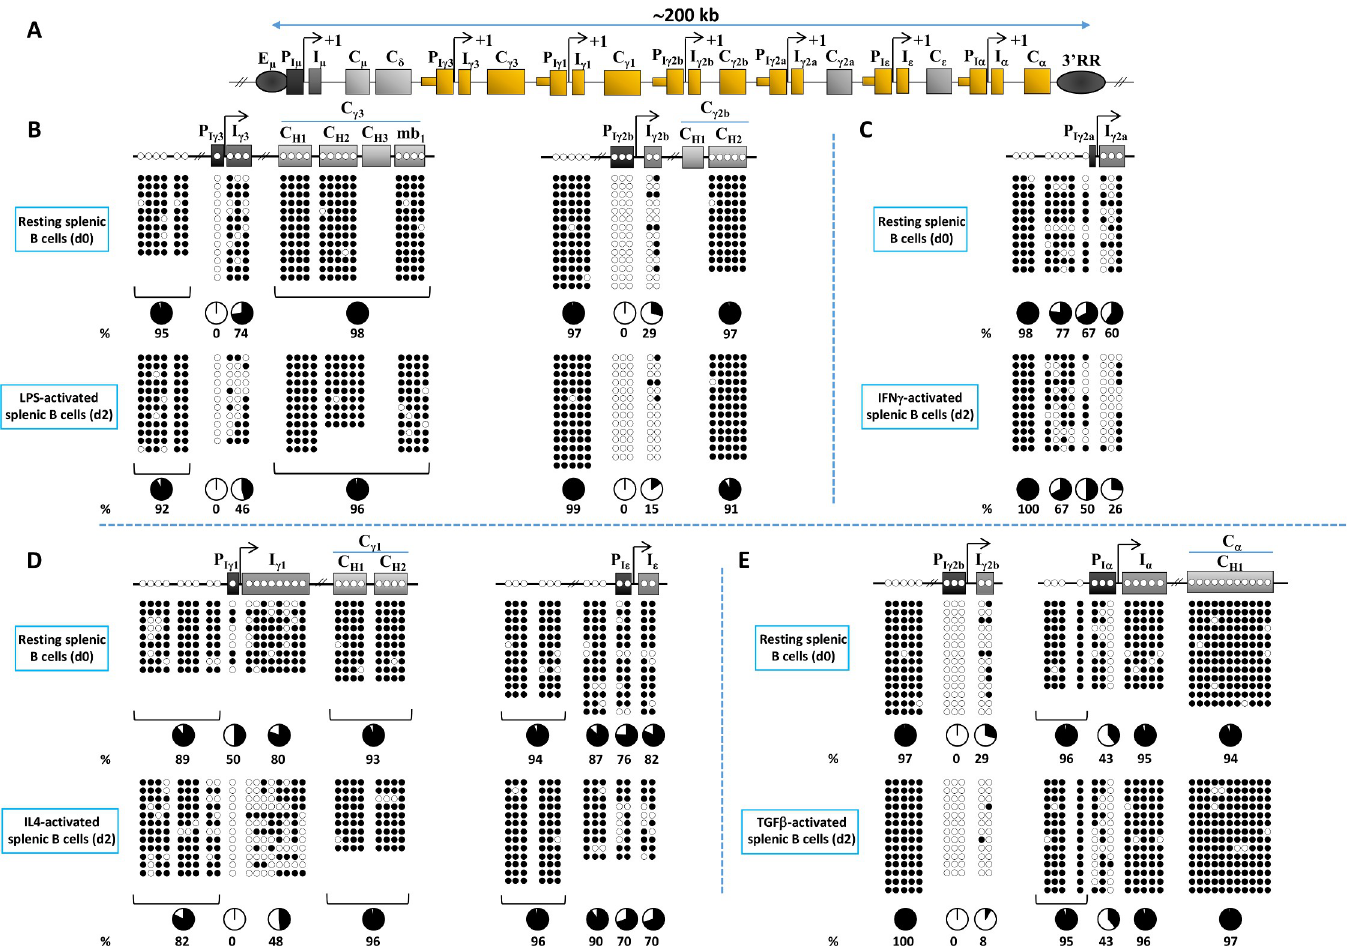
Fig 1. DNA methylation patterns at the IgH constant locus in resting and stimulated splenic B cells. (A) Scheme of the mouse IgH constant locus. The CpGs sequenced map to the regions depicted in orange. These include GL promoters (P Ix ) and upstream regions, I exons (I x ) and C γ 3, C γ 1, C γ 2b and C α exons. Note that the distal CpG at I γ 2b promoter maps right upstream of the distal SMAD3 binding site (see S2 Fig), therefore, there is an uncertainty whether this CpG is truly part of the core promoter. The arrow indicates transcription start site. For convenience, only one initiation site is shown but GL transcripts initiate at multiple sites. E μ enhancer acts as an enhancer and a GL promoter (hence E μ /PI μ ). The 3’RR is also indicated downstream of the locus (not to scale). (B-E) Genomic DNAs were purified from CD43 - WT splenic B cells (d0) and at day 2 (d2) post-stimulation and assayed by bisulphite sequencing. The top panels represent the sequencing results from resting splenic B cells (d0). The bottom panels represent those from activated splenic B cells (d2): (B) LPS stimulation (which induces I γ 3 and I γ 2b promoters), (C) IFN γ stimulation (induces I γ 2a promoter), (D) IL4 stimulation (induces I γ 1 and I ε promoters), (E) TGF β stimulation (induces I γ 2b and I α promoters). The localization of the sequenced CpGs is displayed in the upper schemes. The unmethylated and methylated cytosines are represented by open and filled circles, respectively. The percentage of methylation is indicated underneath the circles for the indicated elements. Note that the panel of I γ 2b region in resting B cells (d0) is the same in (B) and (E). I γ 2a promoter does not contain any CpG, the most proximal lies at 88 bp upstream of RUNX1 binding site. See S2 Fig and S2 Table for additional information on the localization of, and the distance between, the sequenced CpGs.